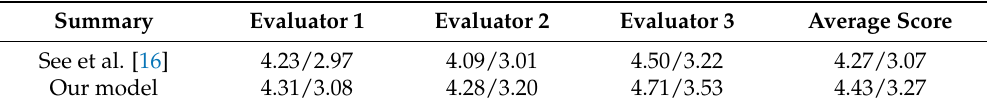
Table 7. Readability evaluation results. See et al. [16] is the summary generated by the model of See et al. [16] and our model is the summary generated by our model. A/B: A represents the score of the syntax and B indicates the score of the grammar.